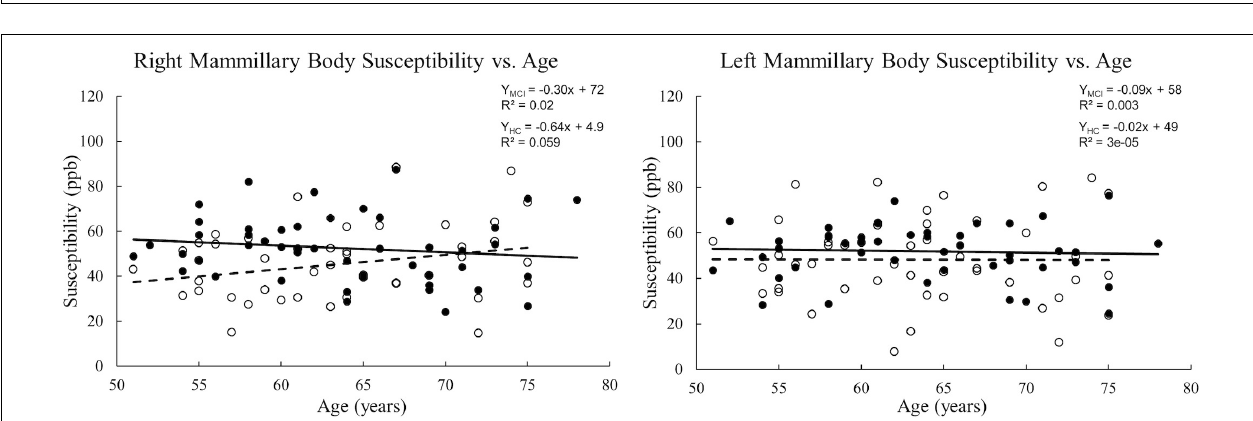
FIGURE 3 | Scatter plots and regression lines for mean susceptibility vs. age for 47 MCI patients and 47 HC subjects. Solid circles: MCI, Open circles: HC. Dotted line: HC, Solid line: MCI. The right and left mammillary bodies are plotted separately. There is no significant change in mean susceptibility with age in either group.